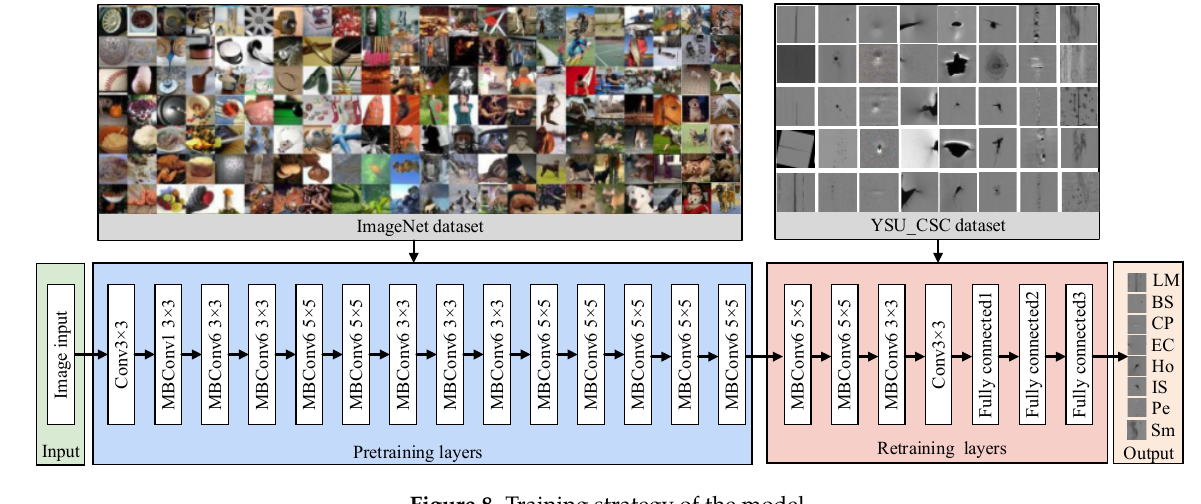
Figure 8. Training strategy of the model.